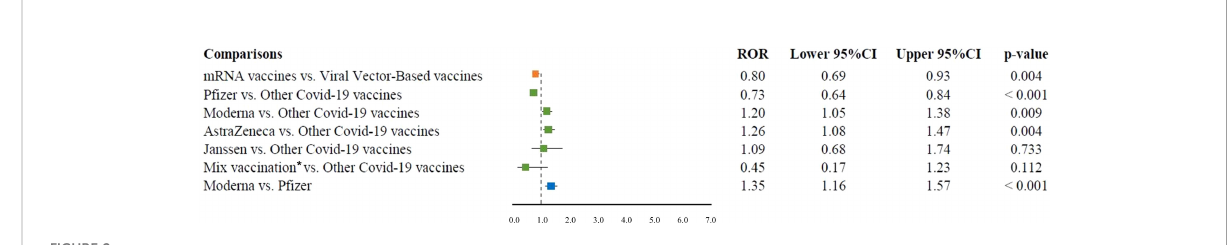
FIGURE 2 ROR of spontaneous abortion for the comparisons between COVID-19 vaccines. ROR, reporting odds ratio; CI, con fi dence interval; mRNA, messenger RNA. *Mix vaccination was represented by the following combinations: Oxford-AstraZeneca/P fi zer-BioNTech, Moderna/P fi zer- BioNTech, and